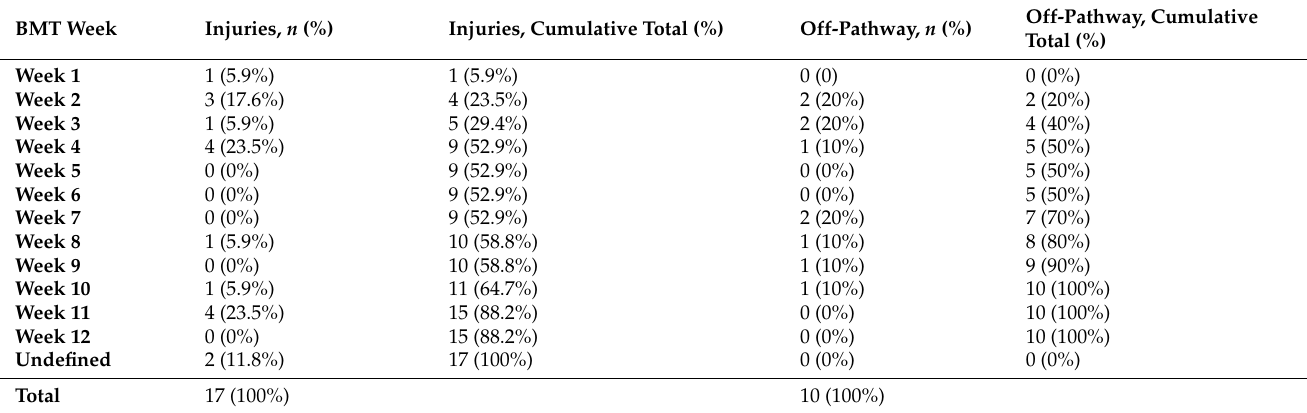
Table 3. The time points of musculoskeletal injuries and the off-pathway incidence during